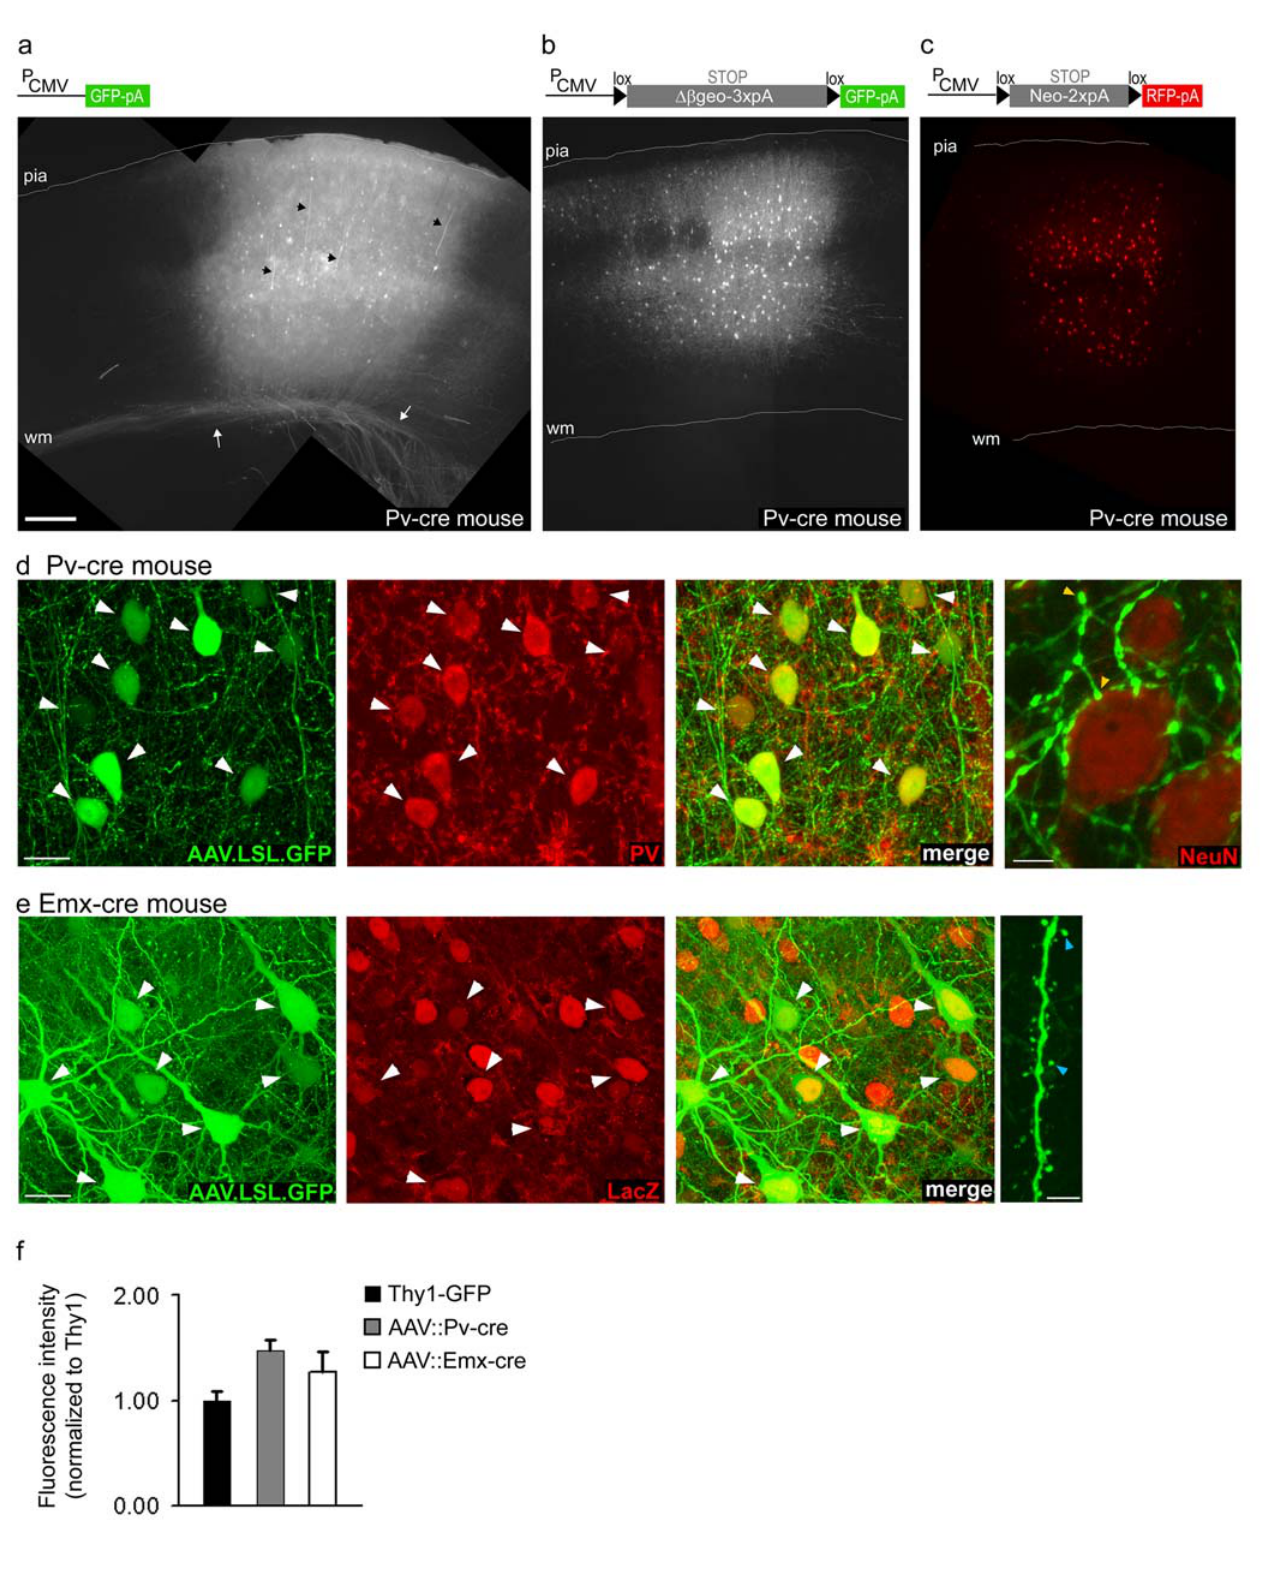
Figure 1. Cre-activated AAV vectors confer cell-type specific and high-level gene expression in brains of Cre knockin mice. (a) Injection of a generic AAV-GFP virus into neocortex of a Pv-cre mouse labeled neurons non-specifically. Pyramids can be recognized by the presence of thick apical dendrites (black arrowheads) and projecting axons (white arrows). (b) Injection of the AAV-lox-STOP-lox (LS 1 L)-GFP virus into the neocortex of a Pv-cre mouse specifically labeled neurons expressing Cre-recombinase. The STOP cassette is shown in gray in the schematic and is